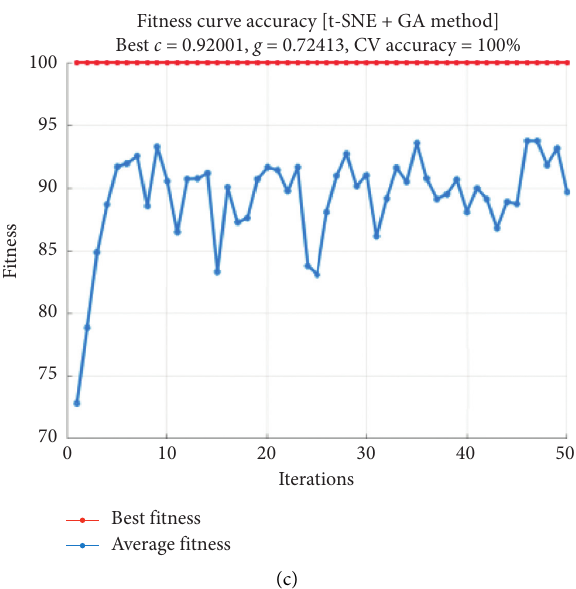
Figure 5: Fitness curve of GA. (a) Fitness curve of No-GA-SVM (best c � 6.8678, g � 0.72413, and CVAccuracy � 99.7917). (b) Fitness curve of PCA-GA-SVM (best c � 13.1126, g � 1.5594, and CVAccuracy � 100%). (c) Fitness curve of t-SNE-GA-SVM (best c � 0.92001, g � 0.72413, and CVAccuracy �